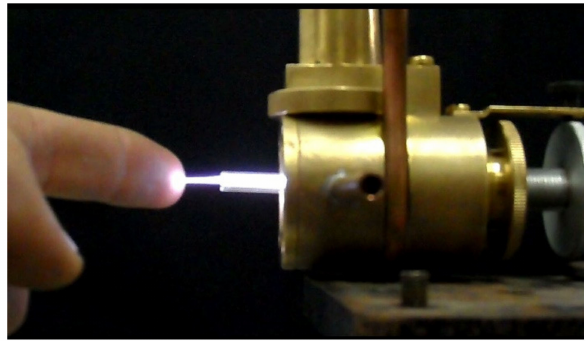
Figure 1. Plasma torch produced by a surfatron wave